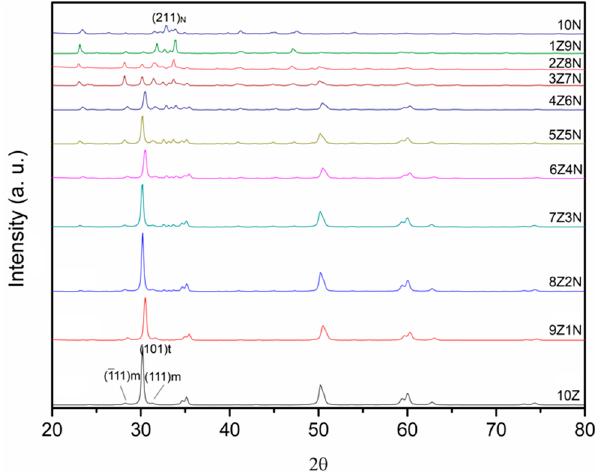
Figure 3. XRD patterns of ZrO 2 mixed with NaCaPO 4 at different weight ratios. With the increase in the blended NaCaPO 4 content, samples 9Z1N and 8Z2N still show similar XRD patterns to that of sample 10Z; however, the intensity of the (101) reflection peak of t-ZrO 2 gradually decreased, and the weak NaCaPO 4 (120) reflection peak first appeared in sample 8Z2N. Secondly, based on the XRD patterns of sample 7Z3N to sample 3Z7N, it can clearly be seen that t-ZrO 2 , m-ZrO 2 , and NaCaPO 4 coexist. Additionally, this reveals that both the quantity and intensity of reflection peaks of NaCaPO 4 increase and that the intensity of the (101) reflection peak of t-ZrO 2 continues decreasing. Interestingly, the relative intensity of the (111) and (111) reflection peaks of m-ZrO 2 becomes continuously stronger. This phenomenon might suggest that NaCaPO 4 inhibits the formation of the t-ZrO 2 phase during the calcination process. Finally, the XRD patterns of samples 3Z7N to 10N almost show the major phase of the NaCaPO 4 , where the peak intensity of ZrO 2 is very weak or even non-existent. Moreover, according to the XRD result and Equation (1) (the calculated t-ZrO 2 phase content is shown in Figure 4), the curve reveals that the tetragonal phase content is almost maintained above 90% from samples 10Z to 7Z3N but linearly decreases from samples 7Z3N to 4Z6N.